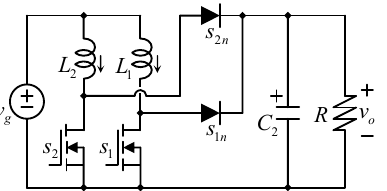
Figure 2. The traditional interleaved boost converter [5].